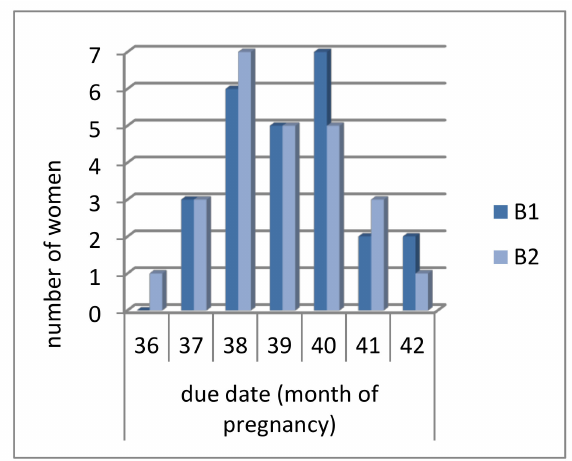
Figure 1. Due date of patients from B1 and B2 group.